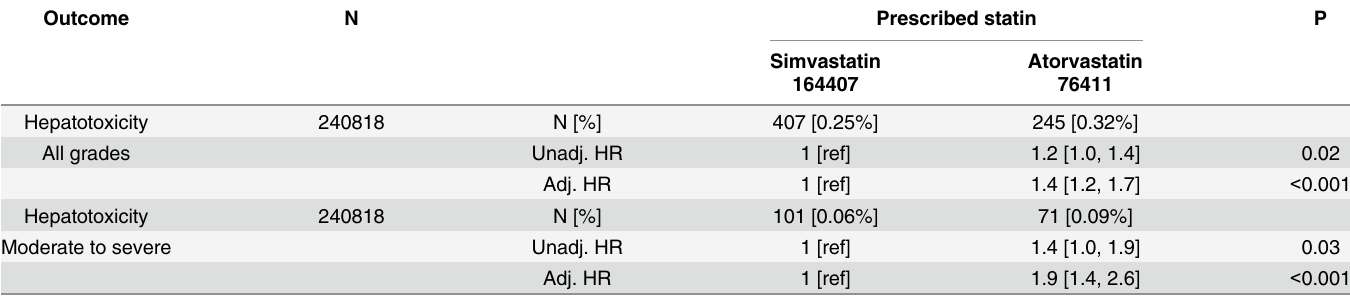
Table 4. Hazard ratio [HR] estimates [95% CI] for significant lab events associated with atorvastatin during the first 6 months therapy on treatment, relative to